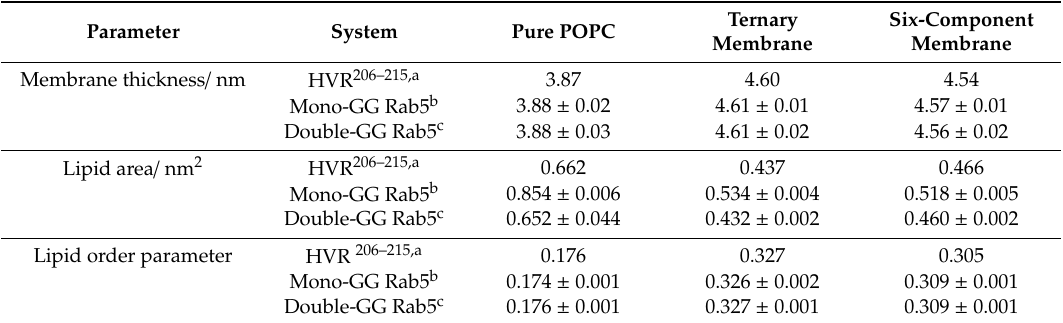
Table 3. Global thickness, lipid area, and average lipid order parameter of the three model membranes when simulated with di ff erent peptide / protein